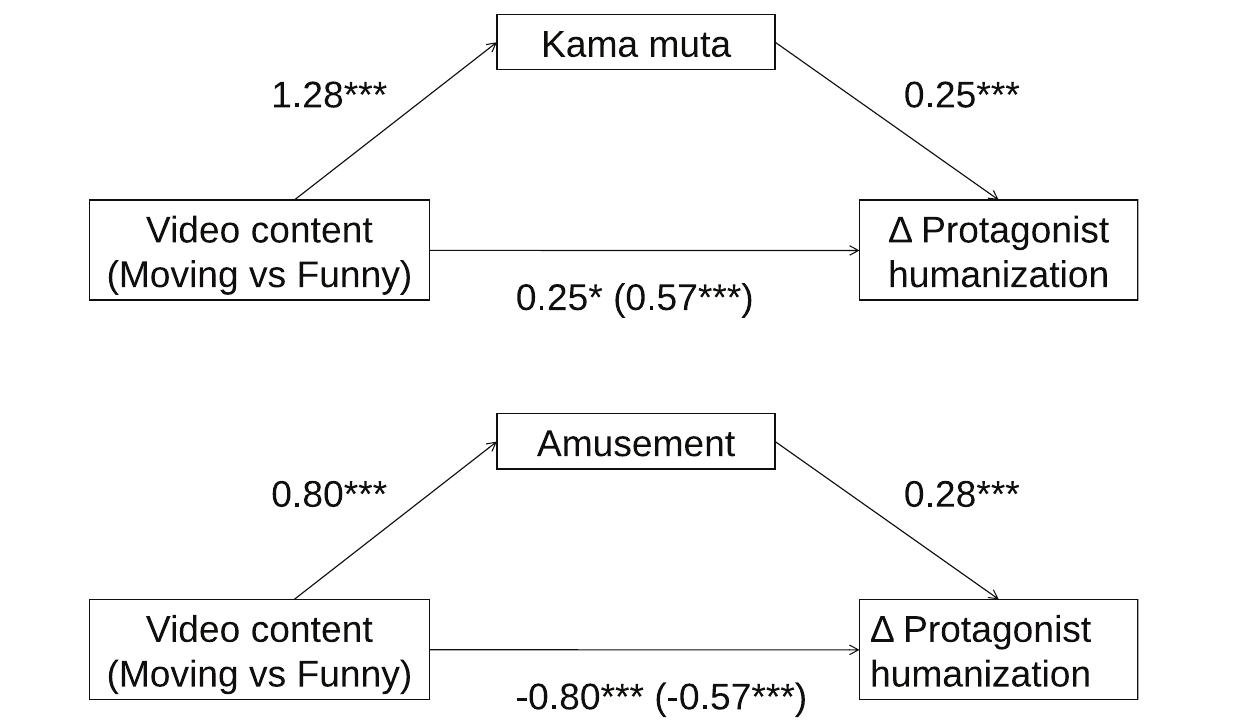
FIGURE 3 | Mediation analyses in Study 2 showing standardized estimates ( z -values). The coding of video content is reversed in the amusement mediation analyses for ease of interpretation. * p < 0.05, *** p <